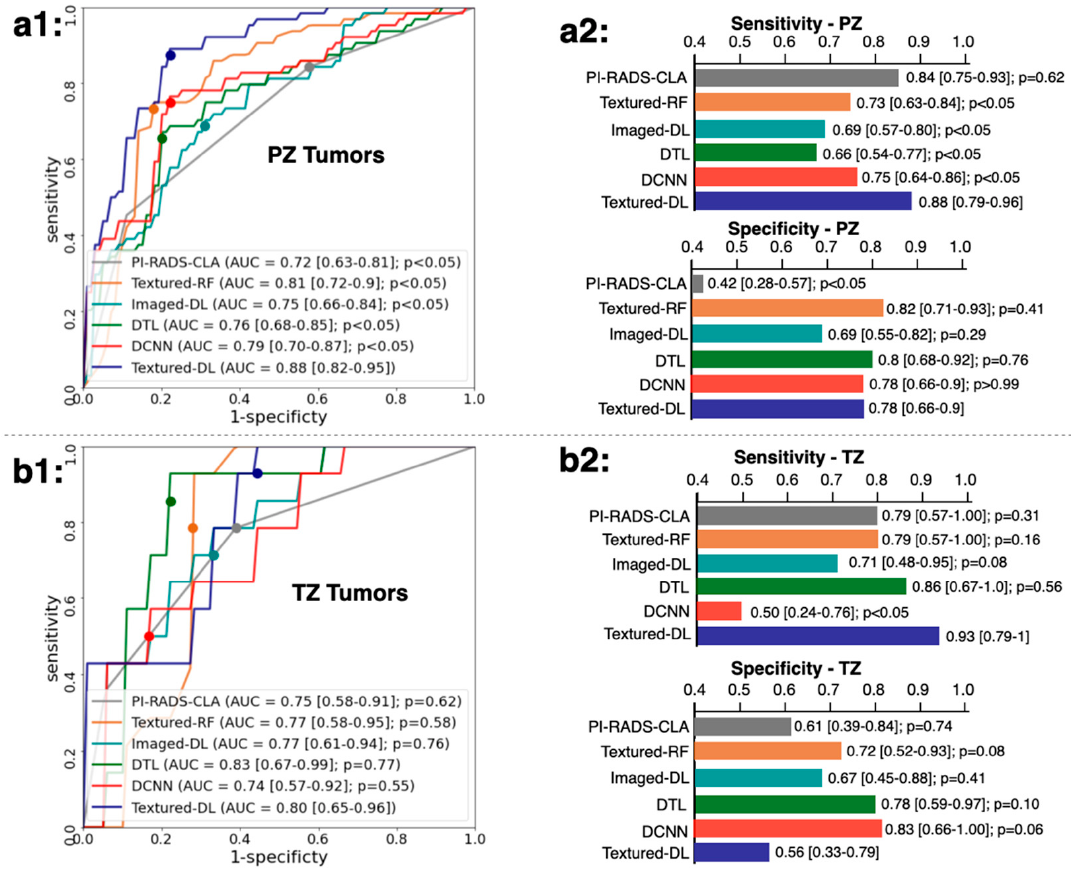
Figure 4. Comparisons of ROC, AUC, sensitivity, and specificity between the Textured-DL and baseline methods in the tumor lesions on the PZ ( a1 , a2 ) and TZ ( b1 , b2 ). CIs are provided in the square brackets. p values for the comparison between the baseline methods and the Textured-DL are also shown.